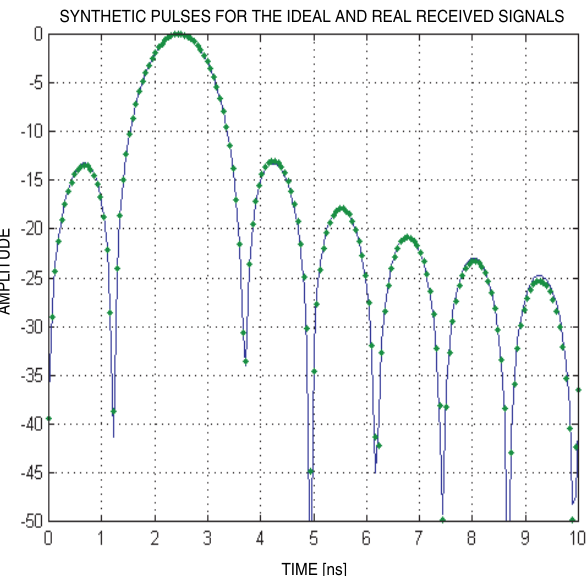
Fig. 12. Comparison of theoretical and received synthetic pulses making use of the stepped frequency signal on the overall band.